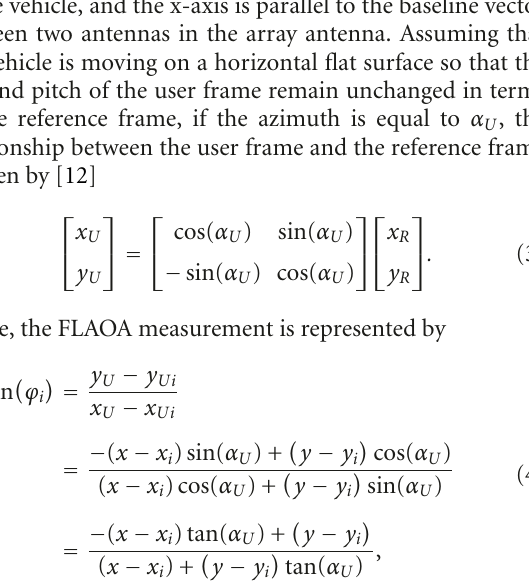
positioning, both the size and power consumption of the sensors can increase owing to the size of the array antenna and due to the complicated array signal processing for the angle